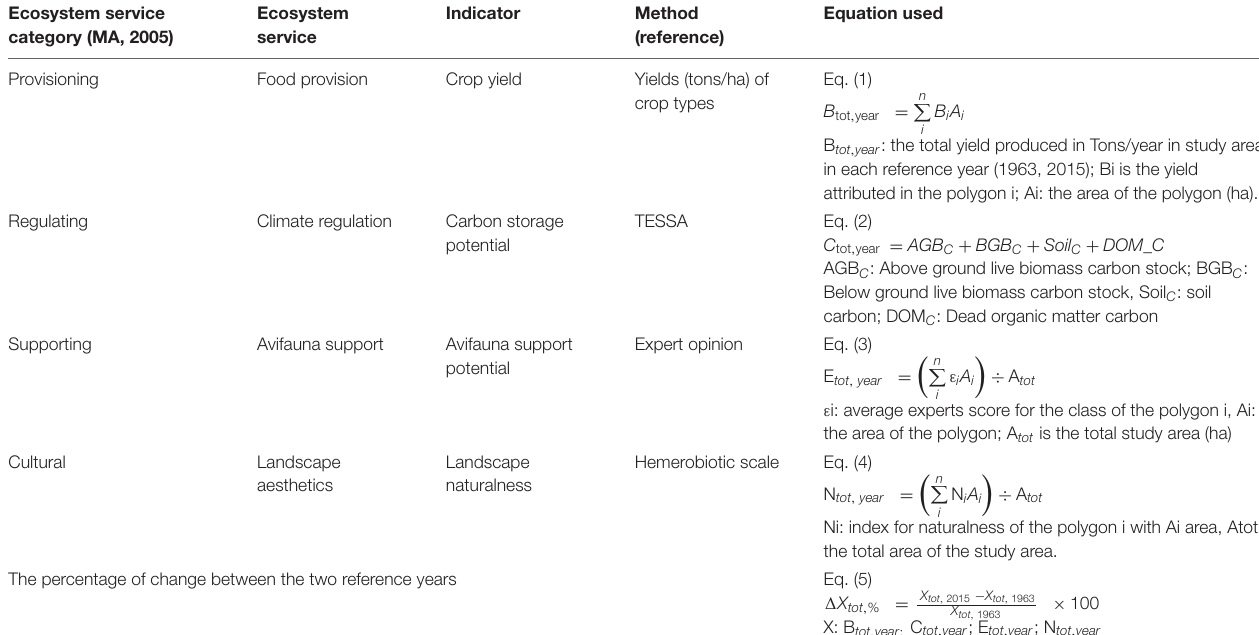
TABLE 1 | Indicators and methods for the estimation of the Ecosystem Services. Ecosystem service category (MA, 2005)